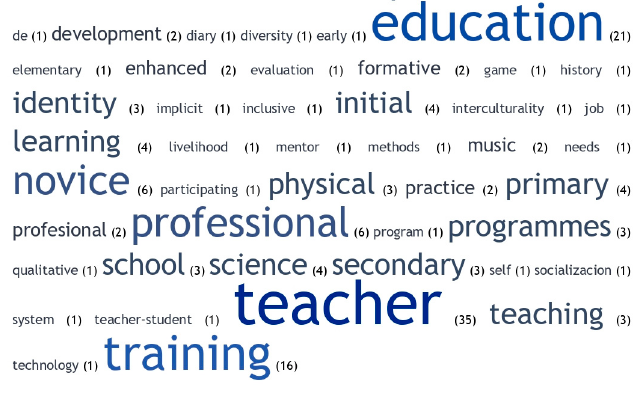
Figure 6. Word cloud for studies of new teachers.